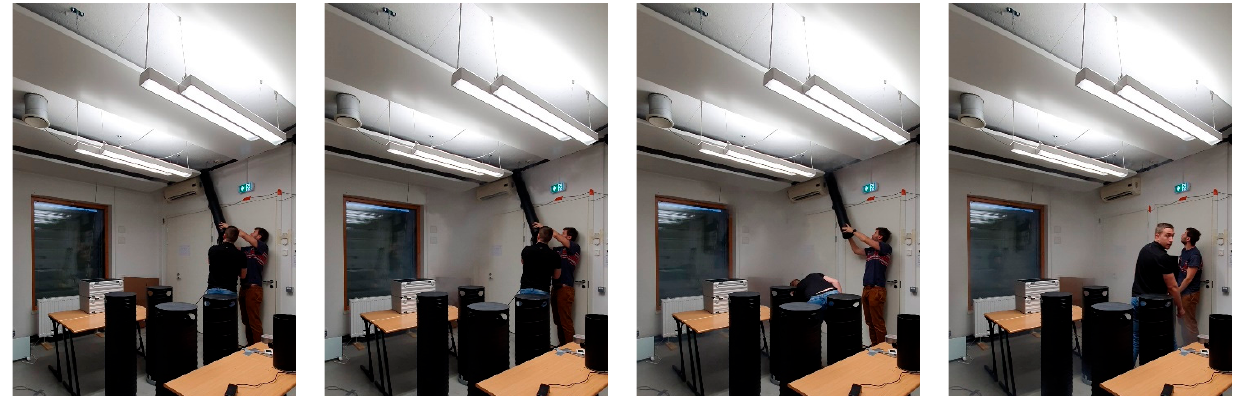
Figure 15. Air circulation pattern of FCUs. Periodic snapshots every 5 s.